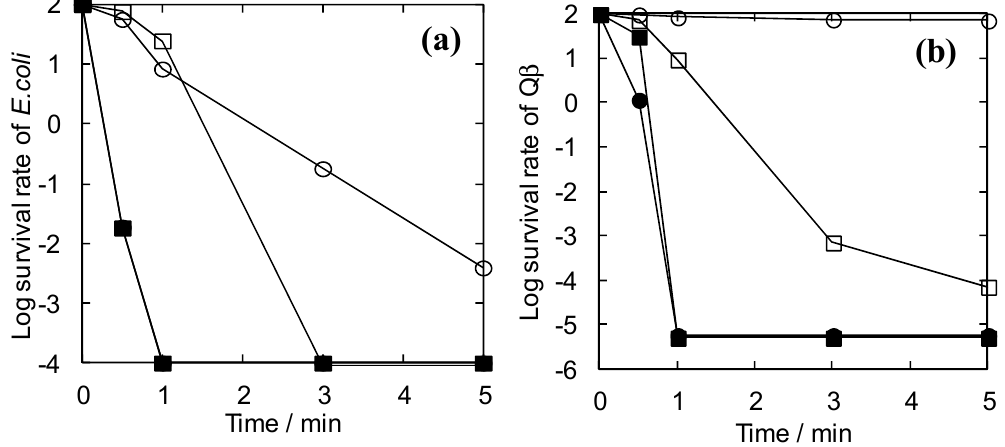
Figure 6. Time course of log survival rate of ( a ) E. coli ; and ( b ) Q β in the water purification system. open circles: UV-C/TMiP reactor; open squares: O squares: O alone (10 mg/L); solid circles: UV-C/TMiP/O 3 with permission from Ochiai et al . [14], Catalysis Science and Technology; published by RSC Publishing, 2011.